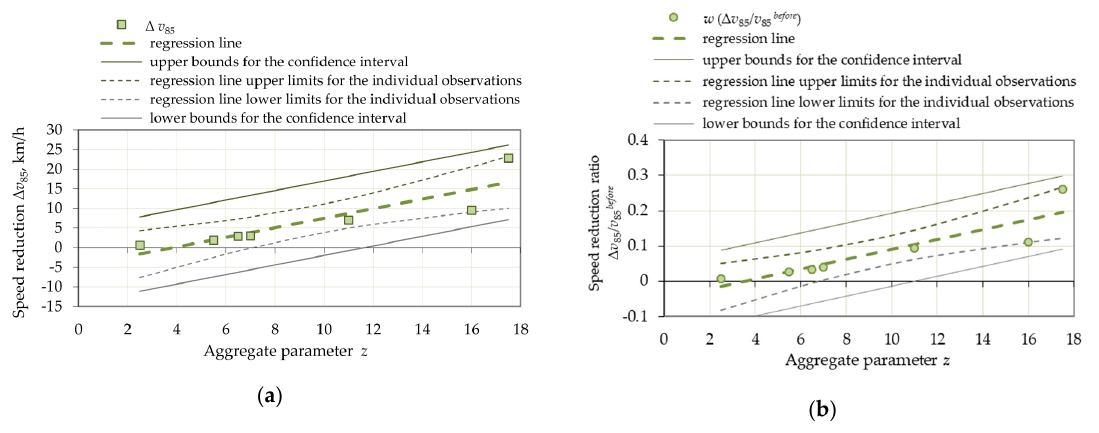
Figure 19. The linear regression function defining the relationships between: ( a ) free-flow speed reduction ∆ v 85 and the aggregate parameter z , ( R = 0.89); ( b ) free-flow speed reduction index w ( v 85 ) and the aggregate parameter z ( R = 0.90).